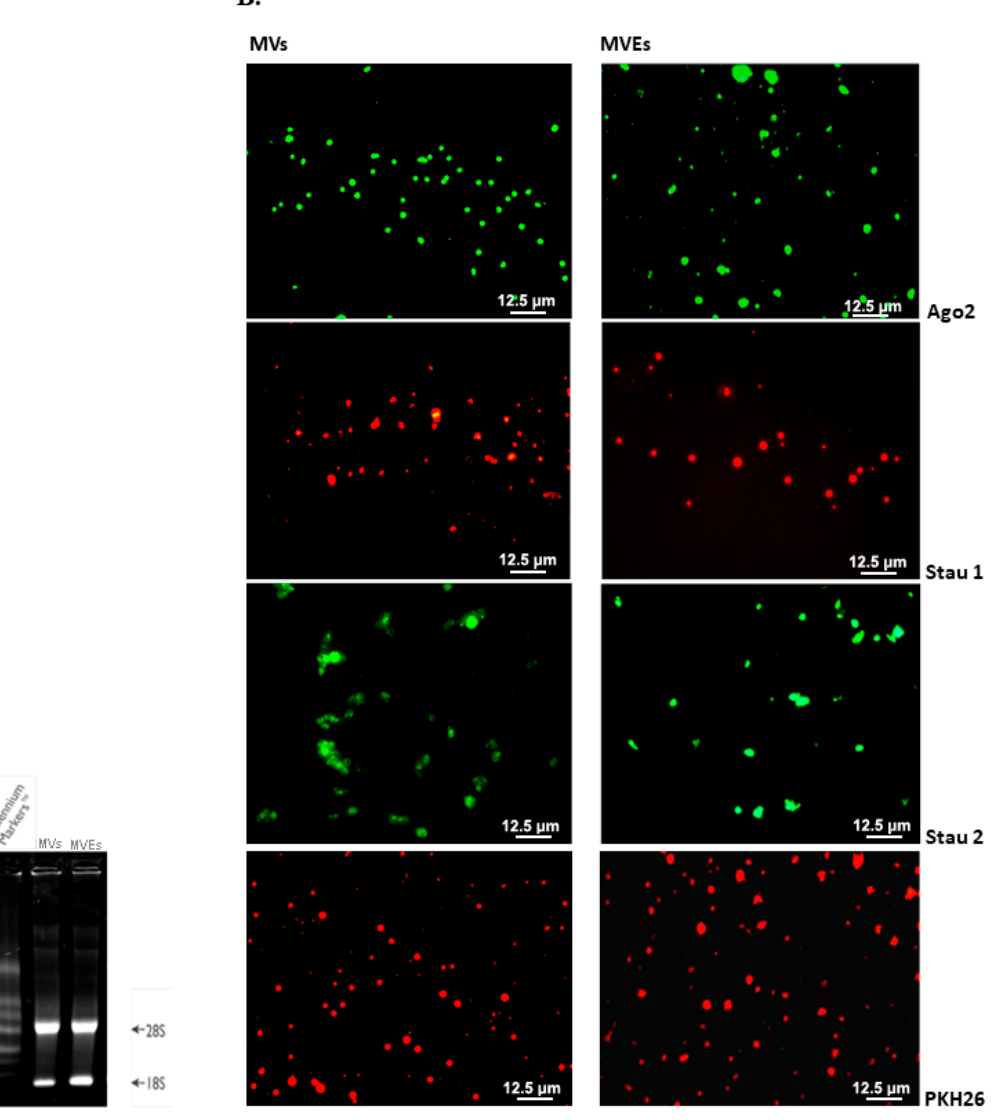
Figure 7. RNA and miRNA-binding proteins analysis in MVs or MVEs from healthy peripheral blood ( n = 3 individual animals per group): ( A ). The presence of ribosomal subunits (rRNAs), 28S (5300 bp) and 18S (2000 bp), on 1% agarose gel demonstrates the integrity of isolated RNAs; ( B ). The appearance of fluorescence suggests that MVs / MVEs shuttle ribonucleoproteins (Ago2, Stau 1, Stau 2) bound to miRNA and involved in its tra ffi c. In addition, the presence of PKH26 labeled MVs or MVEs on slides represents a positive control for the above samples.